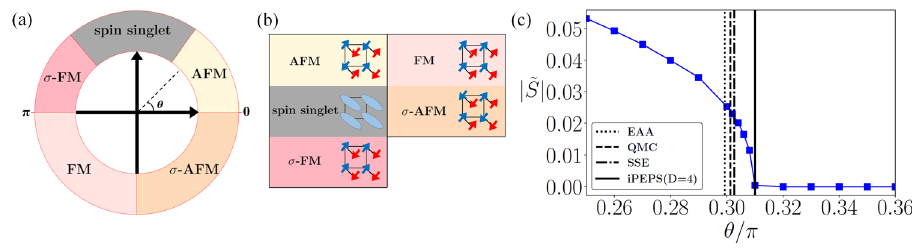
Fig. 1 In fi nite projected entangled-pair state (iPEPS) results at zero fi eld. a Phase diagram versus θ = tan − 1 ( K / J ) (for details, see Eqs. (2) and (3)) of 2D Kondo-necklace model ( Δ = 1.0, given in Eq. (3)) ground states without external fi eld, demonstrated as a hollowed pie chart. Starting from θ = 0, we have in sequence the antiferromagnetic (AFM), spin singlet, σ -ferromagnetic ( σ -FM), ferromagnetic (FM), and σ -antiferromagnetic ( σ -FM) phases as the ground state. The schematic spin con fi guration of each phase is illustrated in b . Blue arrows indicate σ , while red arrows are the Kondo spin moments τ . Light blue ovals represent the local spin singlet on each site. c Plot of j ~ S j order parameter (Eq. (4)) along with θ . We also mark the phase transition points obtained by three other methods, effective analytical approach (EAA), quantum Monte Carlo (QMC), and stochastic series expansion (SSE),